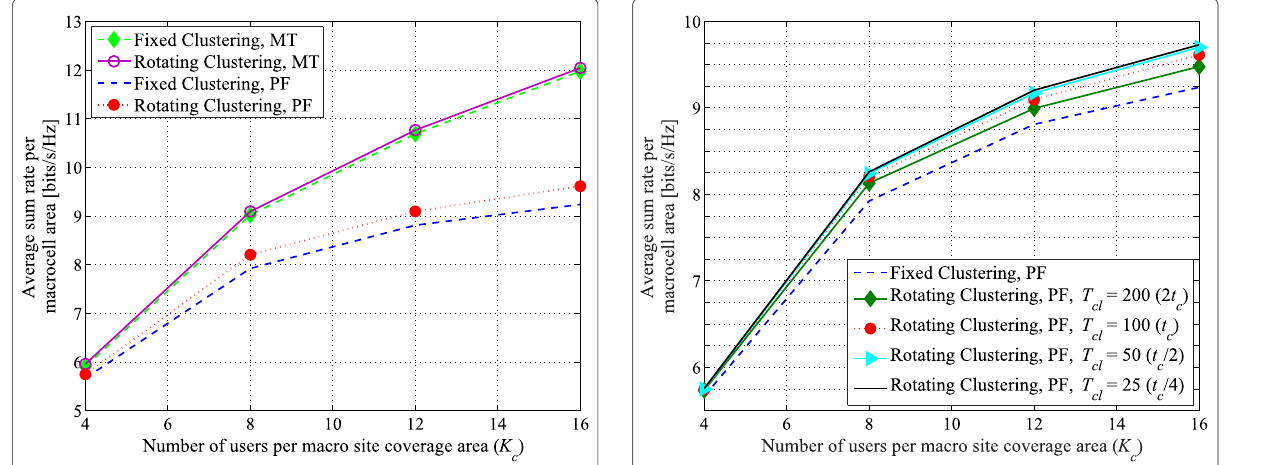
Fig. 5 Average achievable sum rate vs. K c with maximum throughput (MT) and proportionally fair (PF) scheduling metrics over the area of a macrocell in an arbitrary cluster, comparing proposed rotating clustering scheme and fixed clustering for six-cell layout, using simulated annealing scheduling and SZF-DPC precoding. N